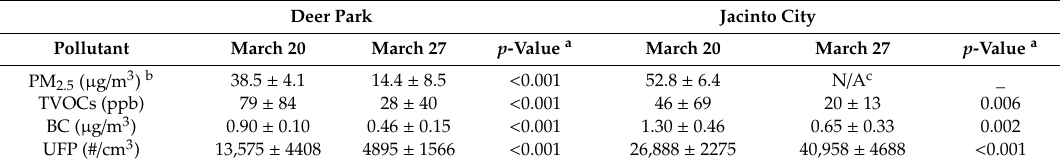
Table 1. Mean ambient air pollutant levels in Deer Park and Jacinto City on 20 March 2019 (during the ITC Fire) and on 27 March 2019 (5 days after the fire was